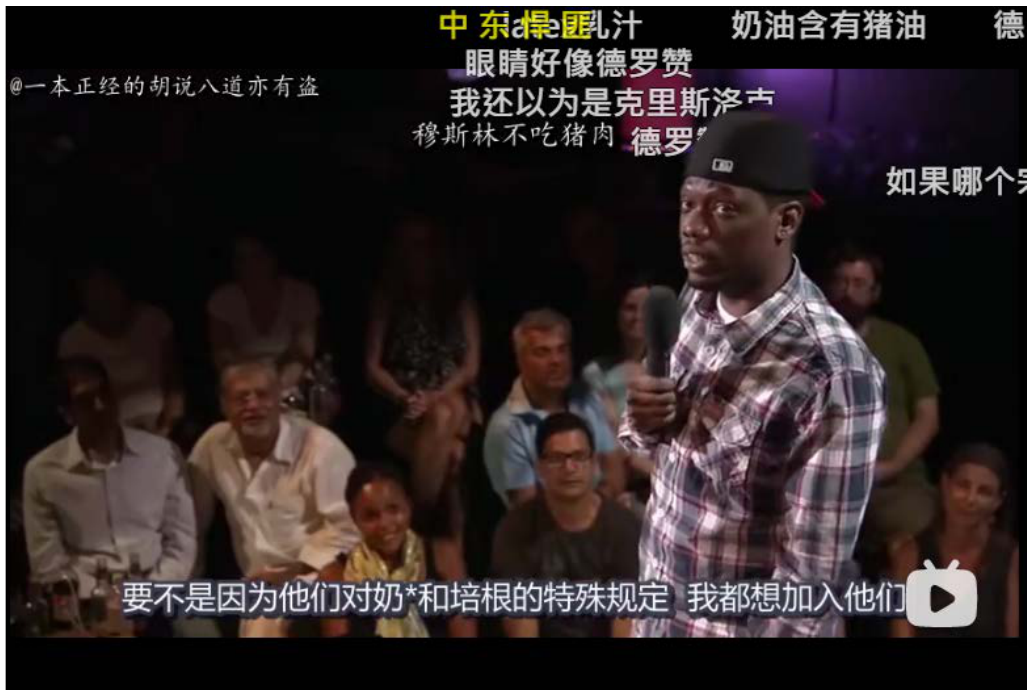
Figure 5. But the viewer who posts danmu 1 does not understand it and thinks it refers to “cream” because cream may be made of lard, and it shares the first character with that taboo word in Chinese. And some of the following danmu comments point out this misunderstanding either by spelling out the English taboo word “ titties ” or explaining the actual in Chinese or English: ST: (I actually liked the religion). I would convert if it would not for the policies on titties and bacon.